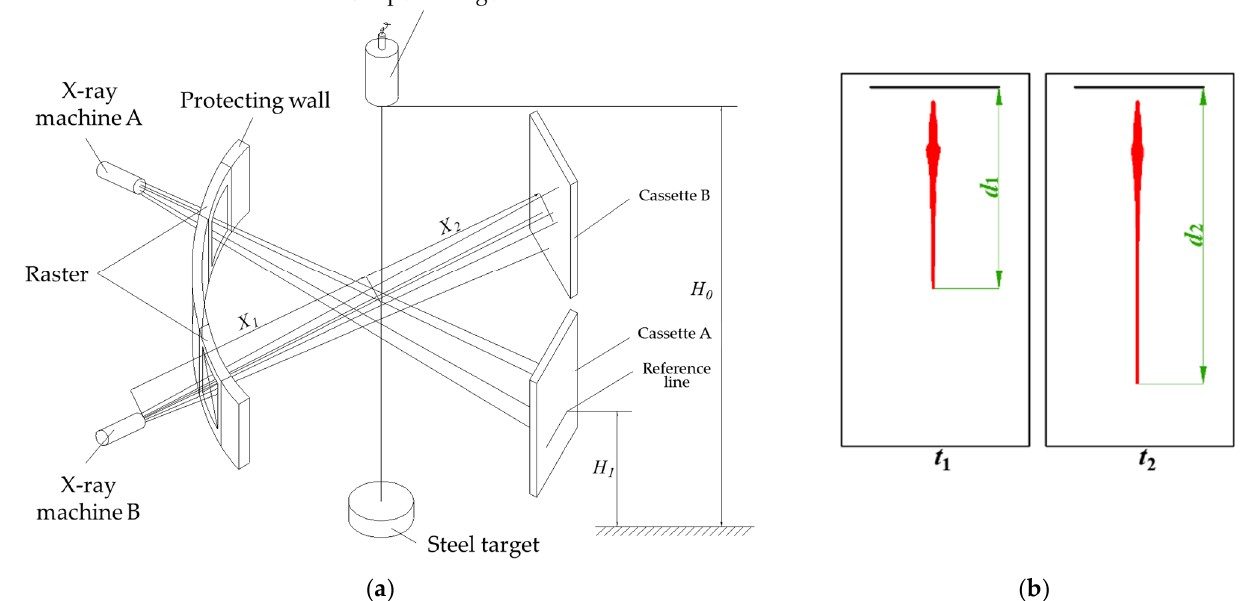
Figure 5. The working-principle diagram of the pulsed X-ray imaging for jets: ( a ) location relationship of the instruments and ( b ) the calculation principle for jet velocity.